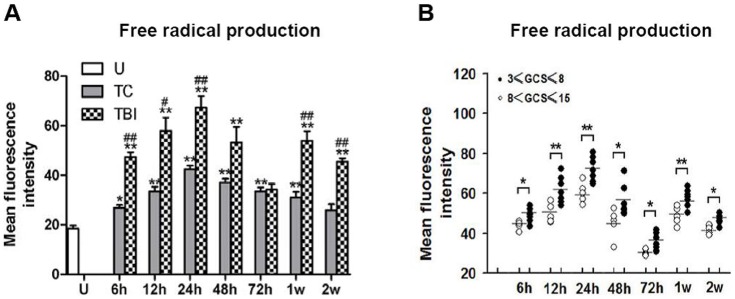
Free radical production in leukocyte homogenates.The presence of free radicals in the leukocytes was estimated by the conversion of DCFH to DCF in homogenates from uninjured (U) subjects and from trauma controls (TC) and traumatic brain injury (TBI) subjects at times ranging from 6 h to 2 weeks after injury. (A) Uninjured subjects (U, open bars) had a few DCF. DCF concentrations increased significantly in TC (grey bars) and TBI (TBI, black bars) subjects at most times assessed. Changes in leukocytes from TBI subjects were greater than those from TC subjects at 6 h, 12 h, 24 h, 1 week and 2 weeks after injury. (B) Futher, mean fluorescence intensity in leukocyte homogenates of six uninjured subjects, twelve TBI subjects with five MTBI (white circles) and seven STBI (black circles) were plotted as a scatter gram. Increases of free radical in leukocytes from STBI subjects were greater than those from MTBI subjects throughout the entire observation period (from 6 h to 2 weeks after injury). **P<0.01; *P<0.05, significantly different from uninjured by Fisher’s protected t tests. ##P<0.01; #P<0.05, significantly different from trauma controls by Fisher’s protected t tests. **P<0.01; *P<0.05, significantly different from MTBI by Fisher’s protected t tests.